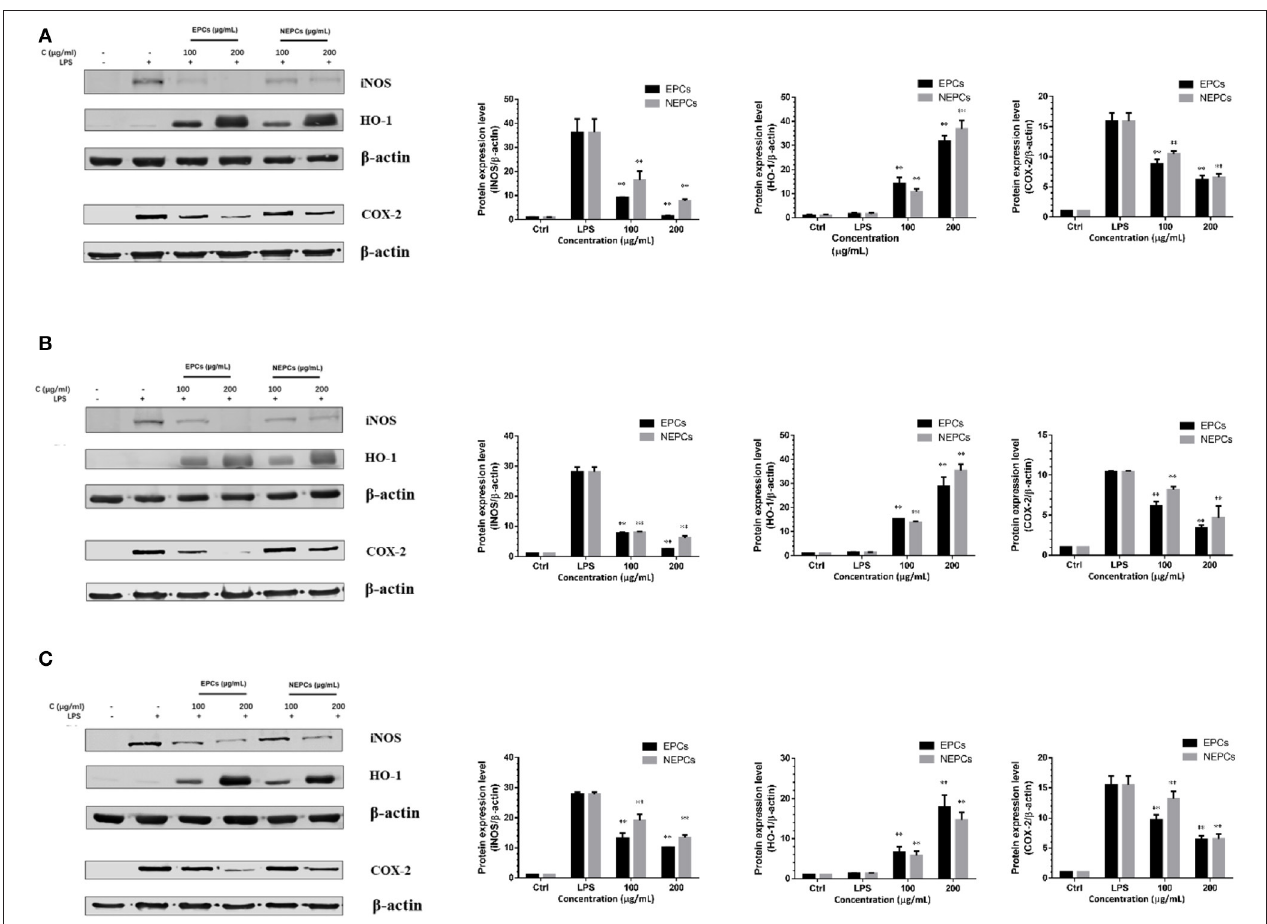
FIGURE 5 | Effects of EPCs and NEPCs from L. japonica (A) , U. lactuca (B) , P. tenera (C) on protein expression of iNOS, COX-2 and HO-1 in activated macrophages. Results were expressed as mean ± SD ( n = 3), * p < 0. 05 and ** p < 0.01 indicate statistically differences from LPS-treated group.